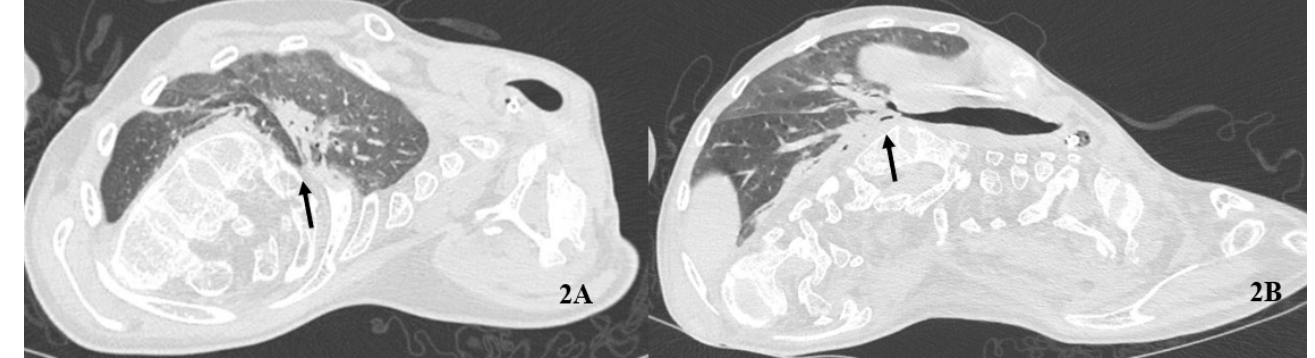
Figure 2. Follow-up computed tomography of the chest. The arrows indicate the sub-total resolution of consolidations at hilum ( A ) and the right lower lobe ( B) .